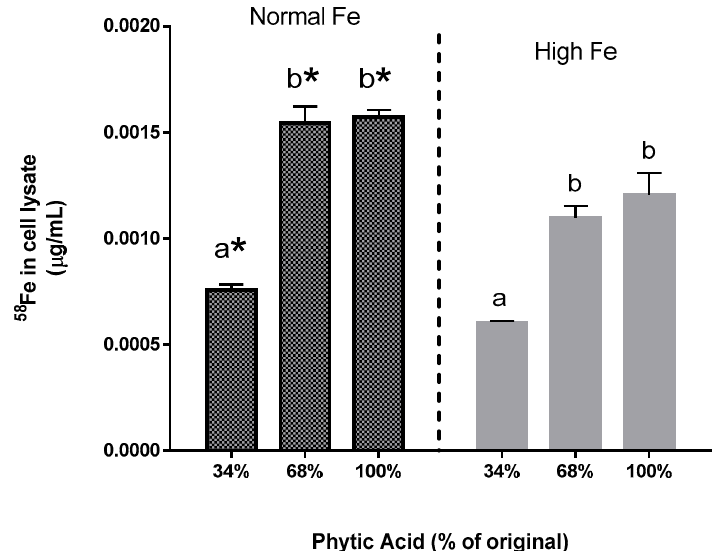
Figure 3. Experiment 4. Caco-2 cell 58 Fe content following exposure to in vitro digests of normal and high Fe beans extrinsically labelled with 58 Fe. Values are mean ± SEM, n = 3. Bars with no letters in common indicate significant difference ( p < 0.05). Asterisks indicate significantly more 58 Fe ( p < 0.05) relative to the same phytate content in the high Fe beans.